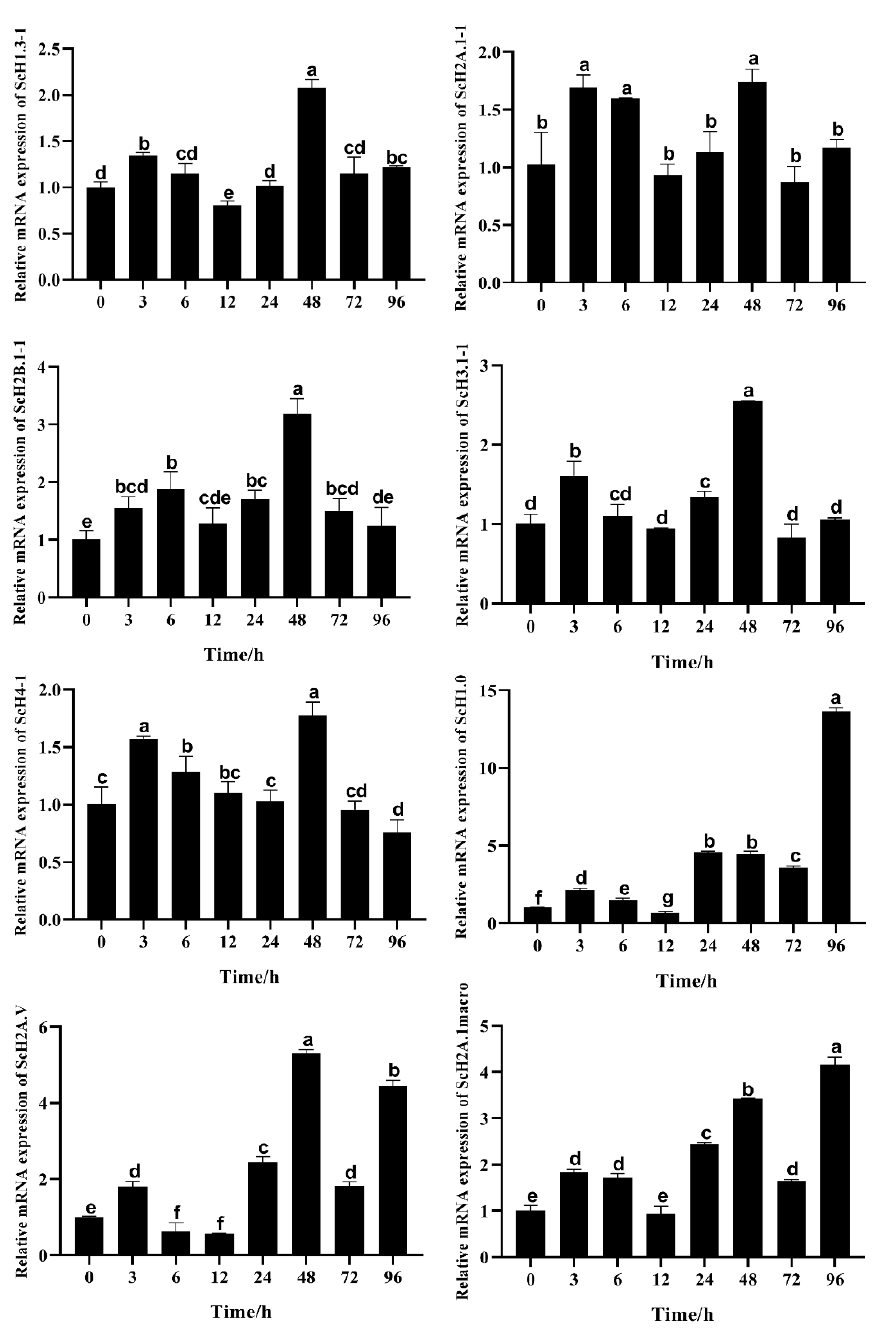
Figure 6. Relative levels of expression of core histones and variants in the gill of S. constricta at different times after V. parahaemolyticus infection. The final concentration of V. parahaemolyticus infection was 1 × 10 8 cfu/mL. Data are represented as mean ± S.E. ( n = 3). Different lowercase letters above the bars indicate significant differences among time-points ( p < 0.05).